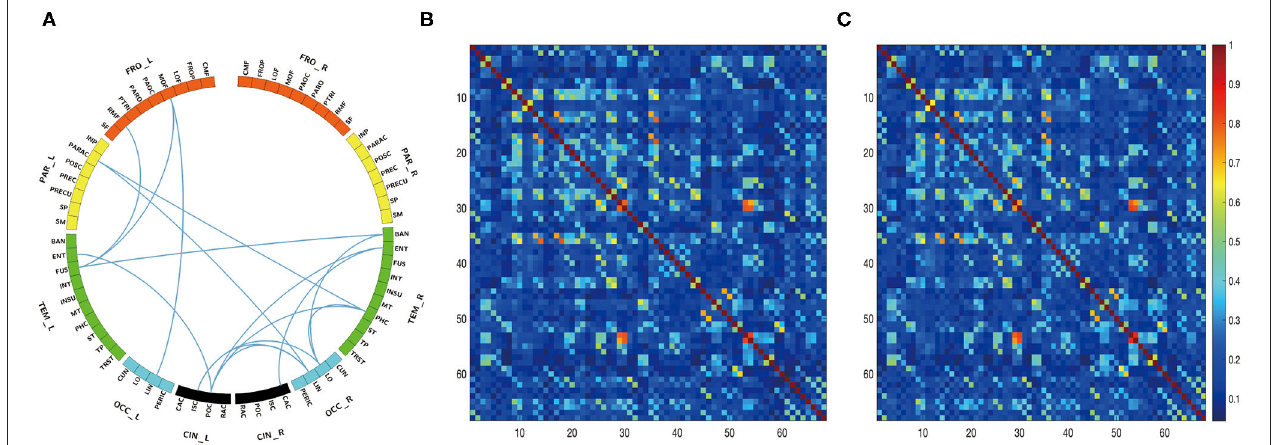
FIGURE 4 | Edgewise significant difference between patients with PD in DBS-OFF and DBS-ON at beta2 frequency band. The circular graph (A) shows the group difference of functional connectivity between two groups. The middle matrix (B) indicates functional connectivity of the group average of patients with PD in DBS-OFF, and the right matrix (C) indicates functional connectivity of the group average of patients with PD in